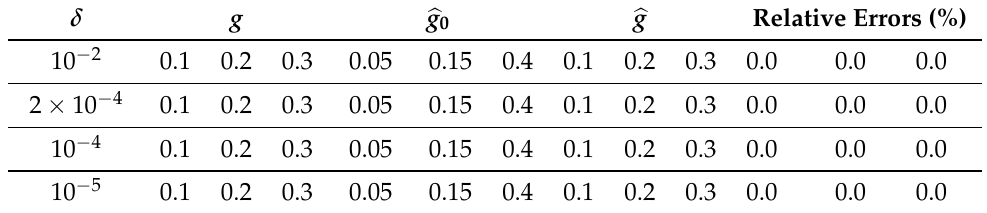
Table 3. Identification results of the observation diffusion elements g .